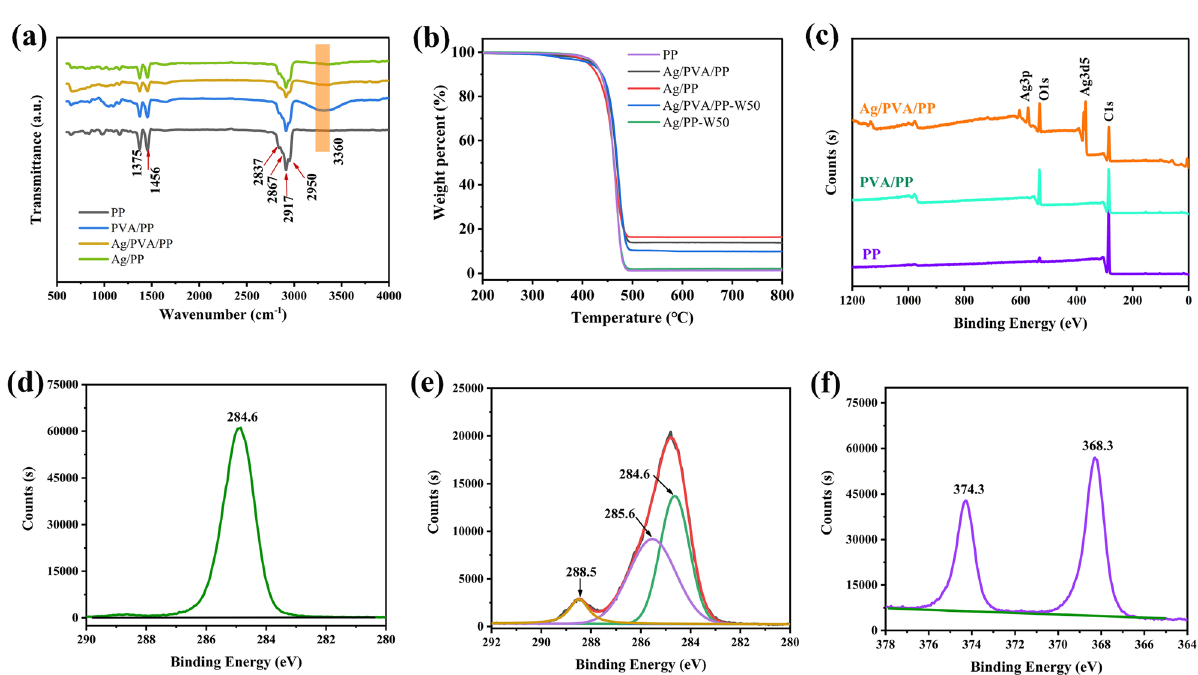
Figure 4. FTIR spectra ( a ), TGA curves ( b ), and XPS survey spectra ( c ) of pure PP, PVA/PP fabric, and Ag/ PVA/PP fabric as well as C 1 s spectra of pure PP ( d ), PVA/PP fabric ( e ), and Ag 3 d peak of Ag/PVA/PP fabric ( f